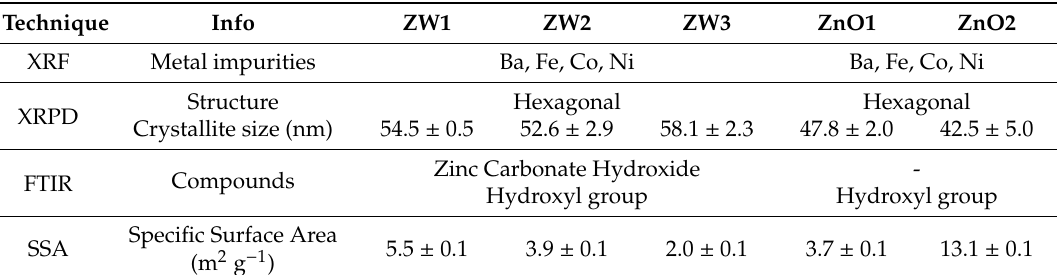
Table 1. Summary of results attained with multiple characterisation techniques providing information on the crystalline structure, specific surface area and elemental impurities or additives in zinc white pigment and zinc oxide